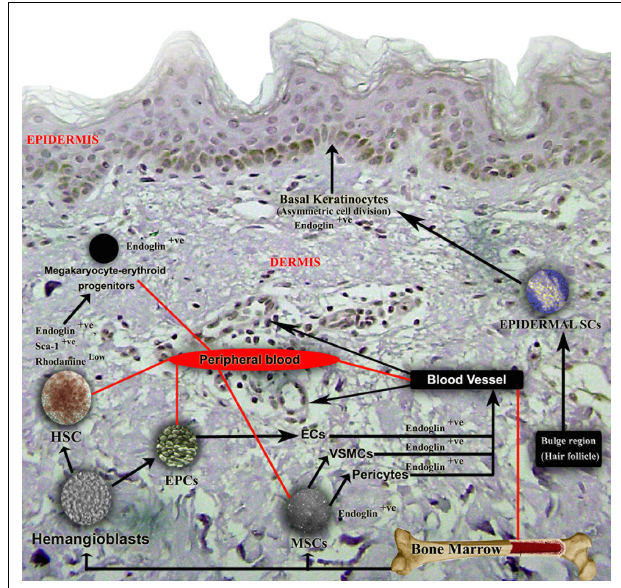
FIGURE 4 | Schematic representation of Endoglin expression in different cell types during the wound healing process. Endoglin is expressed on stem cells and proliferating cells, and is an expression marker for MSCs, HSCs, and megakaryocyte–erythroid progenitors. Eng + 9 and Eng + 7 function as potent hematoendothelial enhancers and Endoglin is expressed in proliferating endothelial cells,VSMCs, pericytes, and basal keratinocytes.The functional role of endoglin on all these cell types in wound healing is not currently well understood.